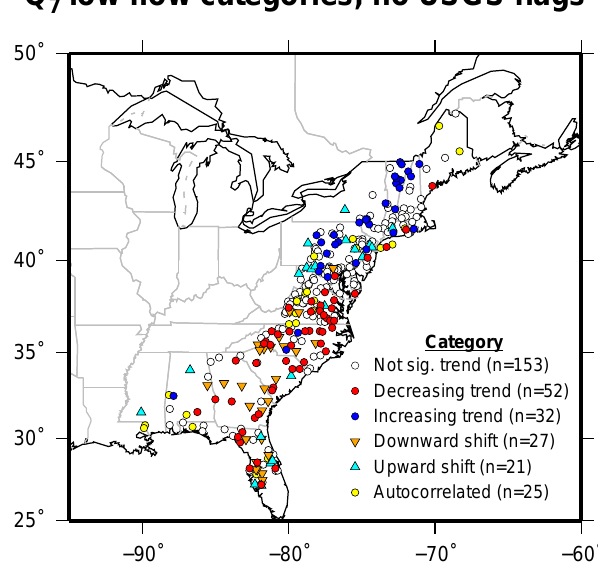
Figure 4. Categorization of nonstationarity of sites for Q7 with no USGS flags from the first step of the decomposition